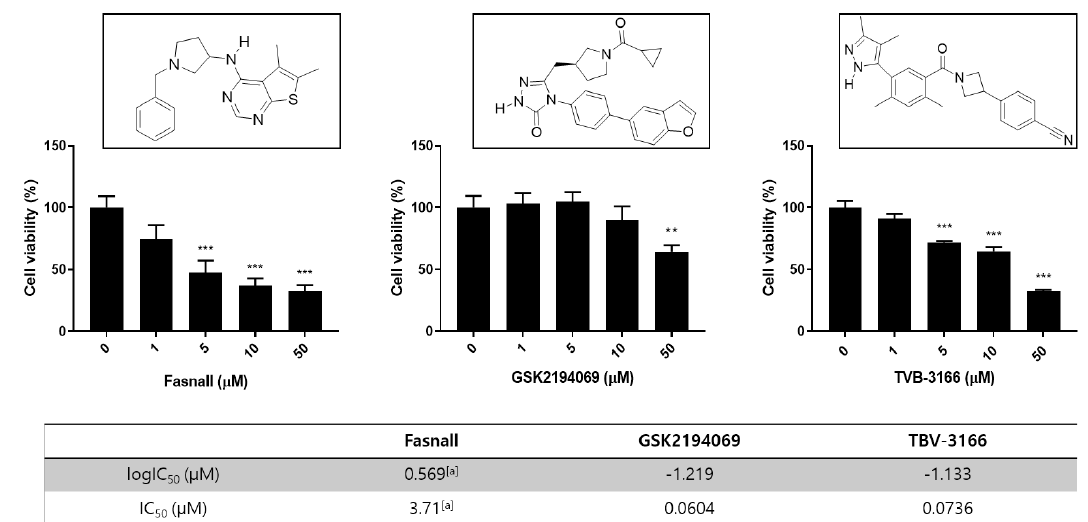
Figure 1. Overview of the chemical structures and cell viability after treatment with FAS inhibitors. Effect of FAS inhibitor treatment on LNCaP-LN3 human prostate cancer cell viability. The LNCaP-LN3 human prostate cancer cells were treated with different concentrations of Fasnall, GSK2194069, or TVB-3166 for 24 h, and cell viability was assayed using the WST-1 assay (mean ± SEM) and FAS inhibition assay with FAS inhibitors. The IC50 values of GSK2194069 and TVB-3166 were measured. (*** p < 0.001, ** p < 0.01).